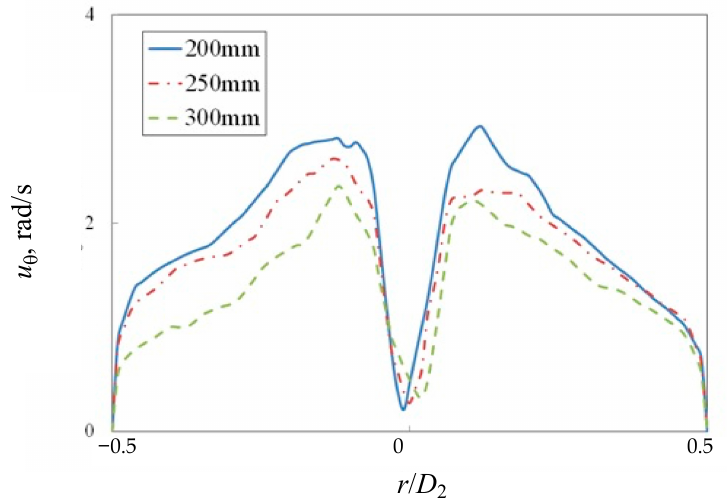
Figure 11. Circumferential velocity contour of the central section. Figure 12 shows the relationship between the maximum gas flow rate and the bubble flow rate when the tank height, H, is changed from the standard 200 to 250 and 300 mm. The higher the tank height, the higher the liquid level and the longer the residence time of the oil, so the fraction of gas flowing out becomes smaller. The higher the height of the oil tank, the more the swirl at the bottom is suppressed, which results in a smaller pressure gradient and fewer bubbles collecting near the surface of the liquid at the center. As a result, the number of bubbles moving toward the outlet pipe in the center decreases, and the number of bubbles flowing out decreases. As a result, the number of bubbles moving toward the outflow pipe in the center decreases. To improve the gas–liquid separation performance, it is effective to increase the height of the oil tank, but it is necessary to consider the balance between increasing the amount of oil and increasing the